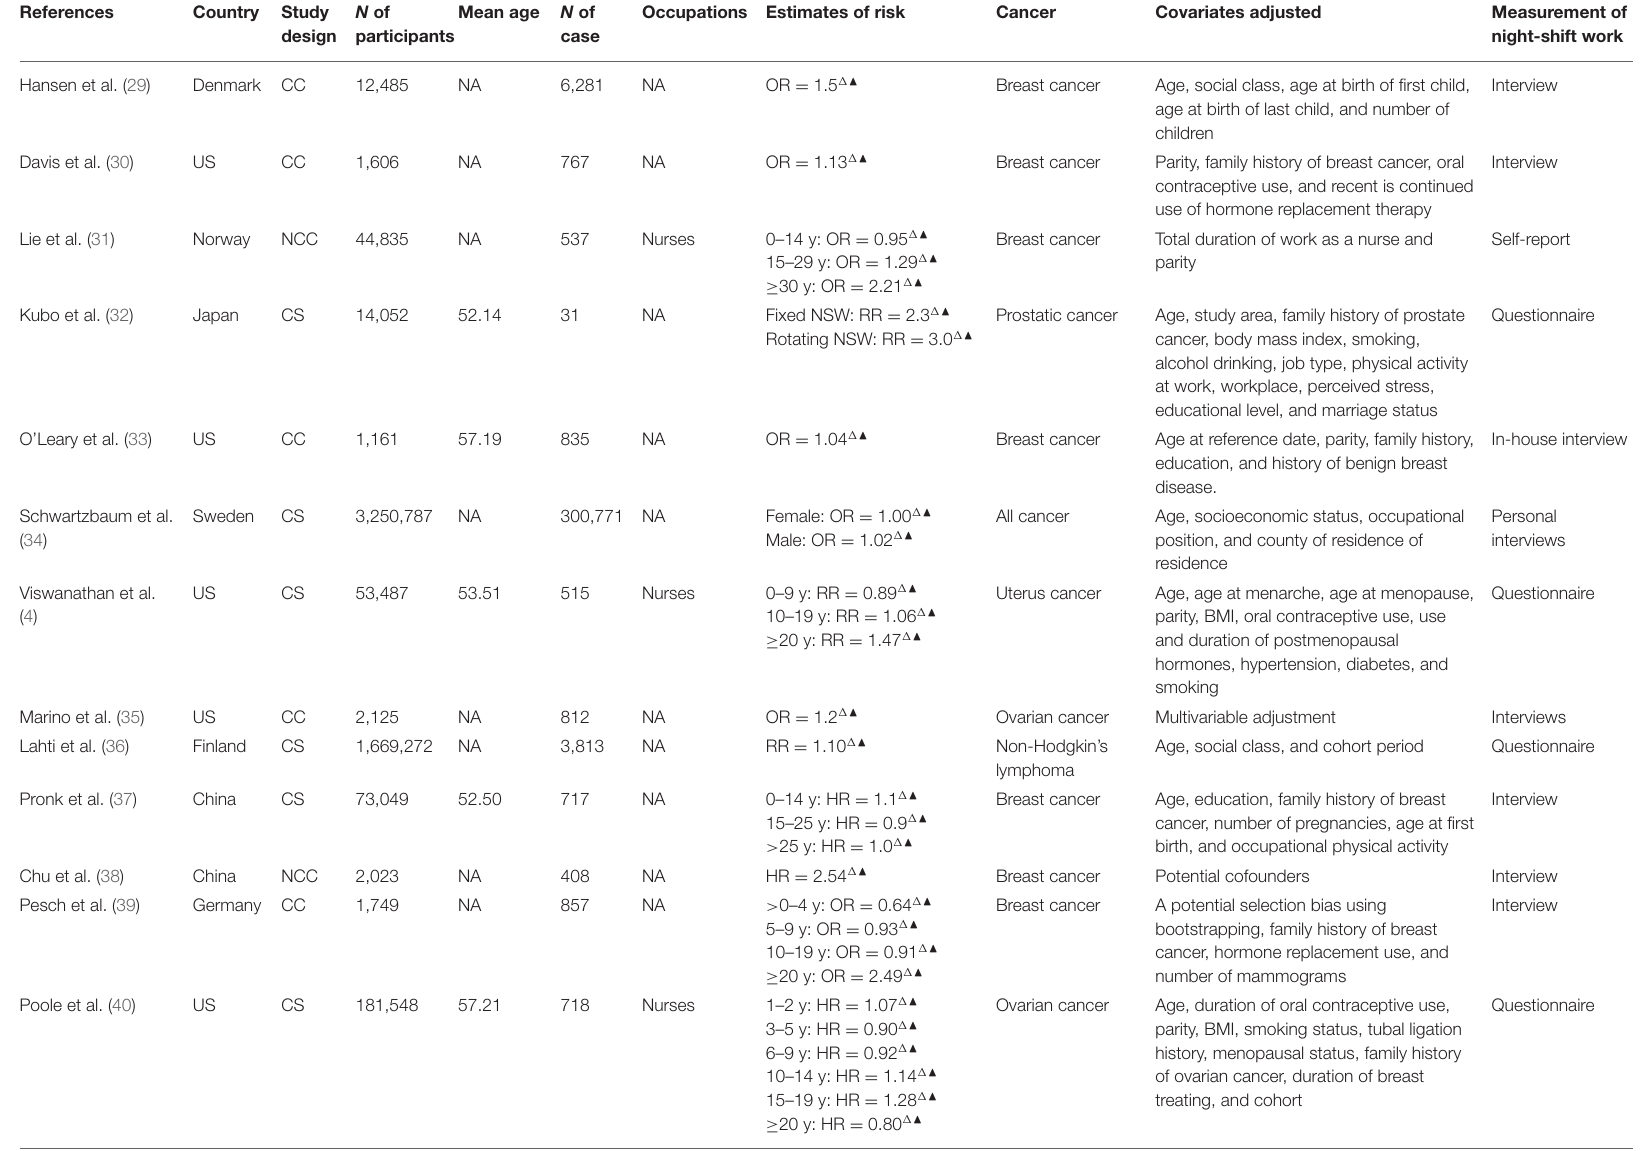
TABLE 1 | Characteristics of included studies.